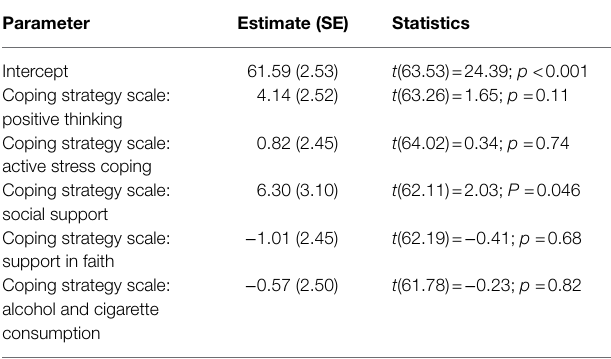
TABLE 5 | Results of the multilevel model investigating the effects of coping styles on situational coping for